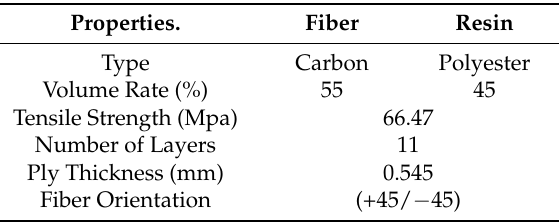
Table 1. The features of composites.